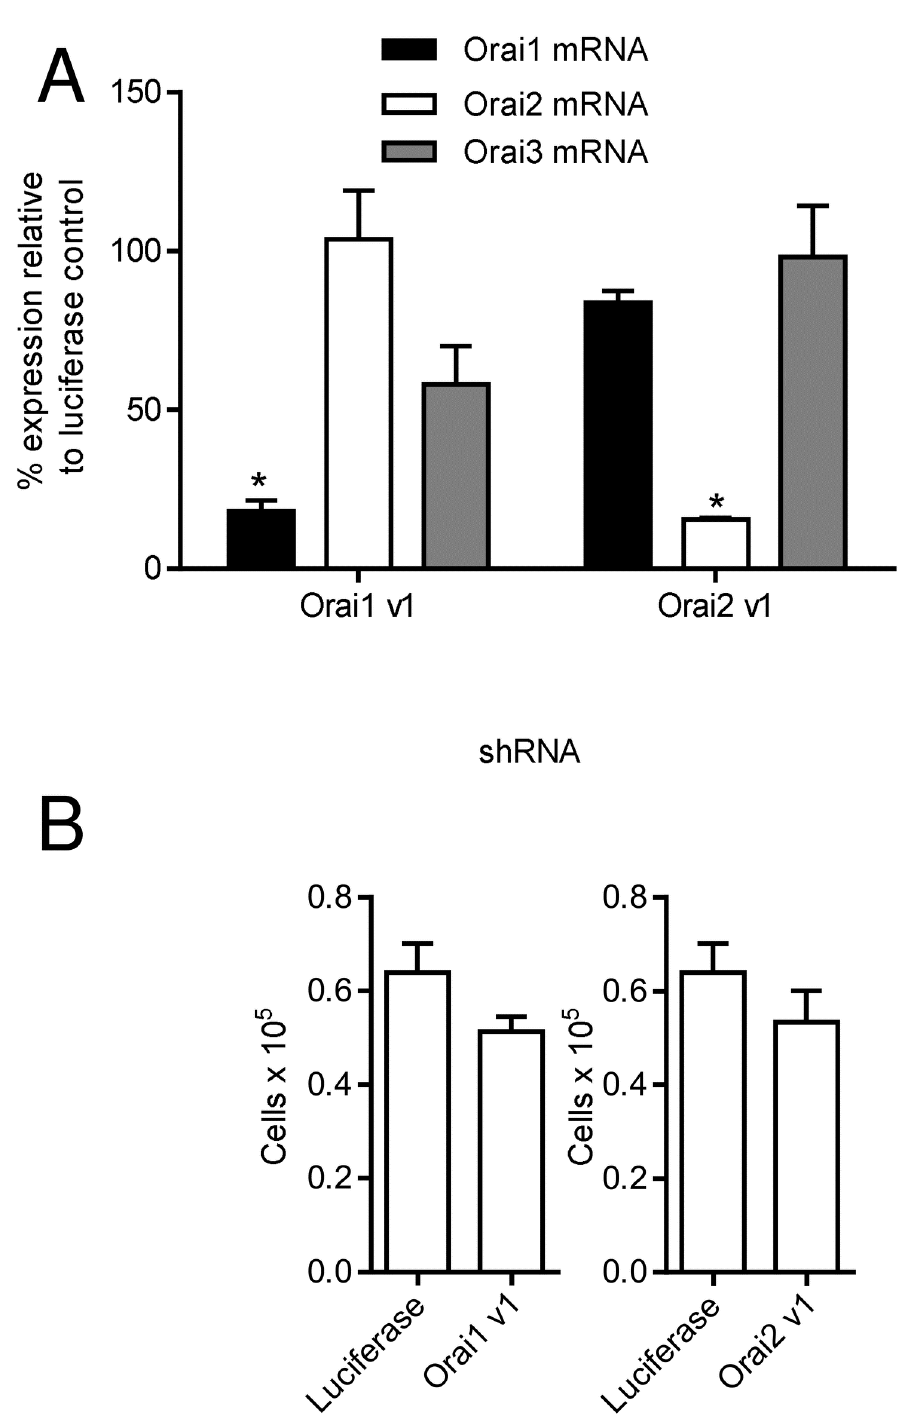
Figure 1. Knockdown of Orai channels using recombinant adenoviruses expressing shRNA. ( A ) Knockdown efficiency of shRNAs against Orai1 (Orai1 v1) and Orai2 (Orai2 v1) was determined in HLMCs 4 days following transduction with virus by quantitative RT-PCR (n=3 independent experiments using HLMCs from 3 donors), * p<0.05 compared to expression in cells transduced with luciferase control. All other conditions were not significantly different to control. ( B ) Transduction of HLMCs with adenoviruses expressing shRNAs against Orai1 (Orai1 v1) and Orai2 (Orai2 v1) (n=3 donors), had no significant effect on cell viability after 4 days compared to luciferase control virus. doi: 10.1371/journal.pone.0074895.g001 PLOS ONE |